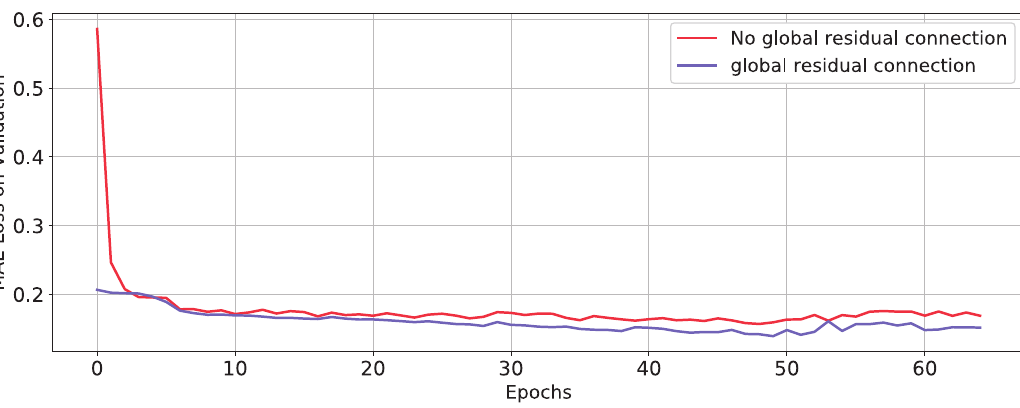
Figure 7. Global residual connection validation losses. The validation losses of the model which has global residual connection are slightly lower than the model does not have; at the beginning of training, the former has significant lower loss than the